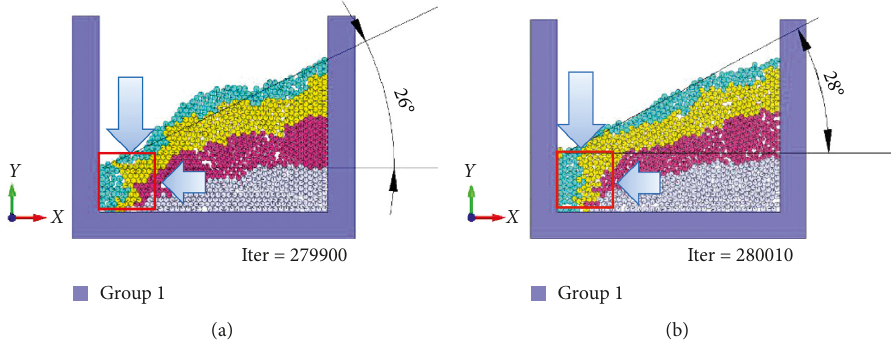
Figure 10: 0.1m coal with different natural repose angle and excavation left lower part 1m × 1m. (a) Natural repose angle is 16 ° . (b) Natural repose angle is 26 °